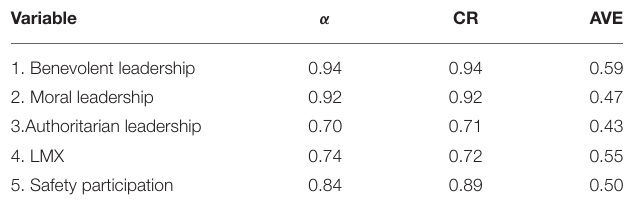
TABLE 3 | Reliability and validity for study